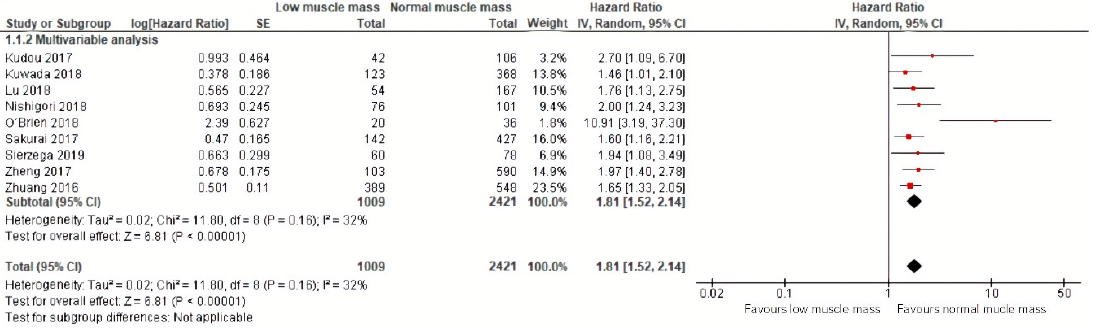
Figure 5. Forest plots of univariable and multivariable hazard ratios for overall mortality for gastric cancer patients with low muscle mass versus normal muscle mass.